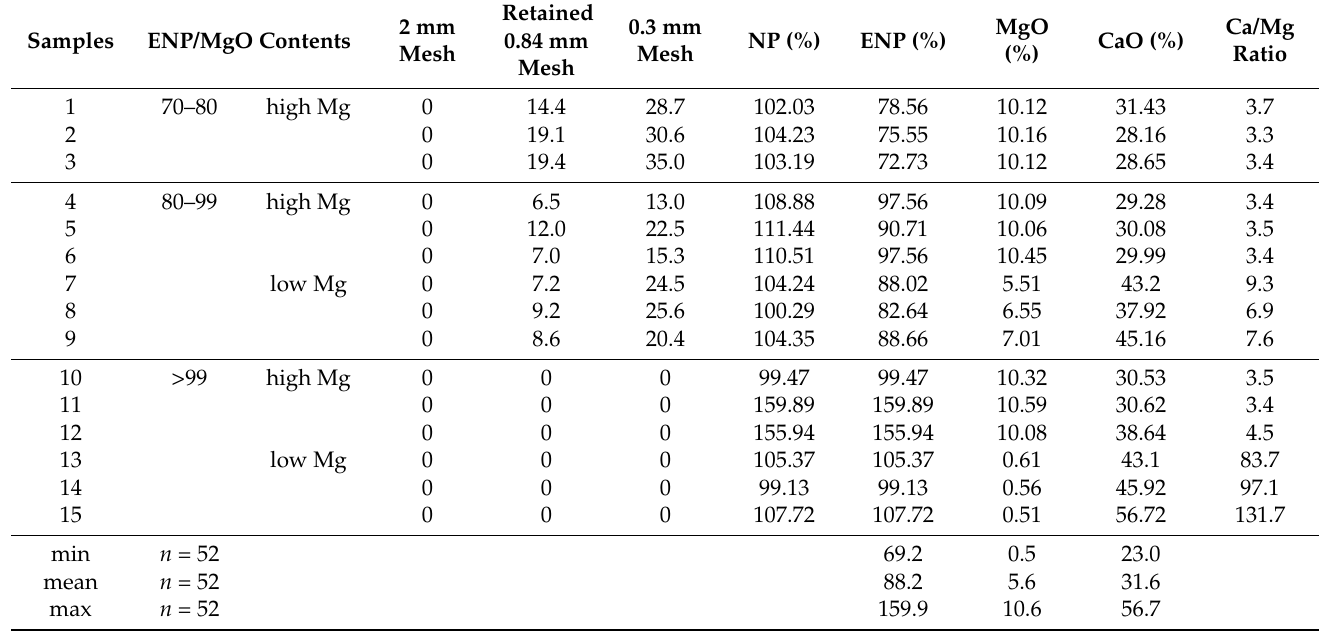
Table 1. Groups of limestones/correctives product samples based on the efficiency neutralizing power and MgO and CaO